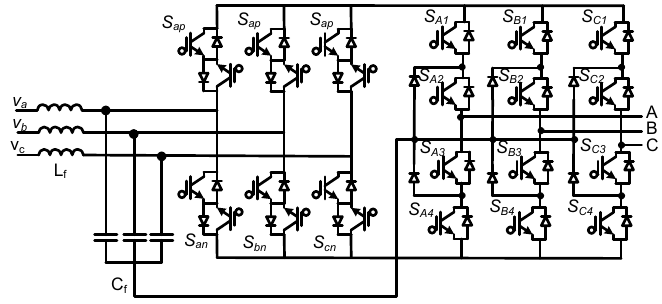
Figure 2. The conventional NPC multilevel Indirect Matrix Converter.